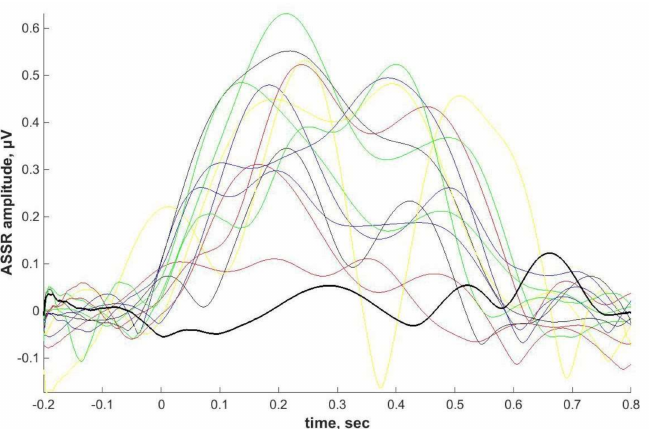
Figure A1. Individual values ( µ V) of 40-Hz ASSR obtained after Hilbert transform for age-matched comparison group (‘old’) and values of SH01 (presented in bold black). The time of stimulus presentation is 0.